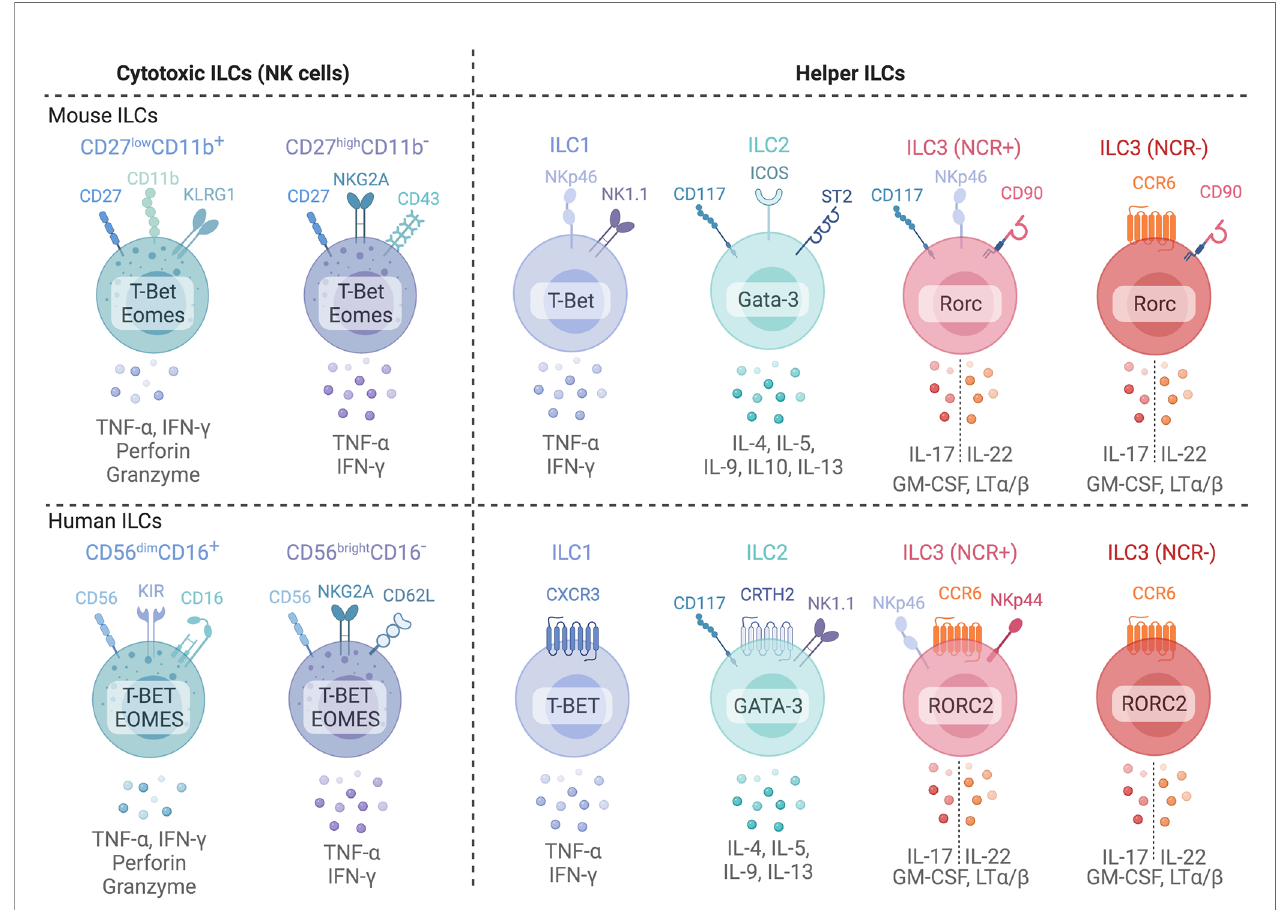
FIGURE 1 | Common phenotypic markers of mice (top) and human (bottom) ILCs and their common cytokine expression pro fi les. Cytotoxic Natural Killer cells can be subdivided into two major subsets based on surface marker expression in both mice and humans. In mice, NK cells are subdivided into two subsets based on CD27 and CD11b expression: CD27 high CD11b - immature NK cells and mature CD27 low CD11b + NK cells. In humans, CD56 bright CD16 - and CD56 dim CD16 + are generally used to identify immature and mature NK cells in blood. However, tissue NK cells often display a CD56 bright CD16 - phenotype. ILC1s, ILC2s, and ILC3s are classi fi ed based on surface marker and transcription factor expression pro fi les that parallel CD4 + T helper subsets. ILC3s are further subdivided into natural cytotoxicity receptor (NCR) + and NCR - subsets. Created with